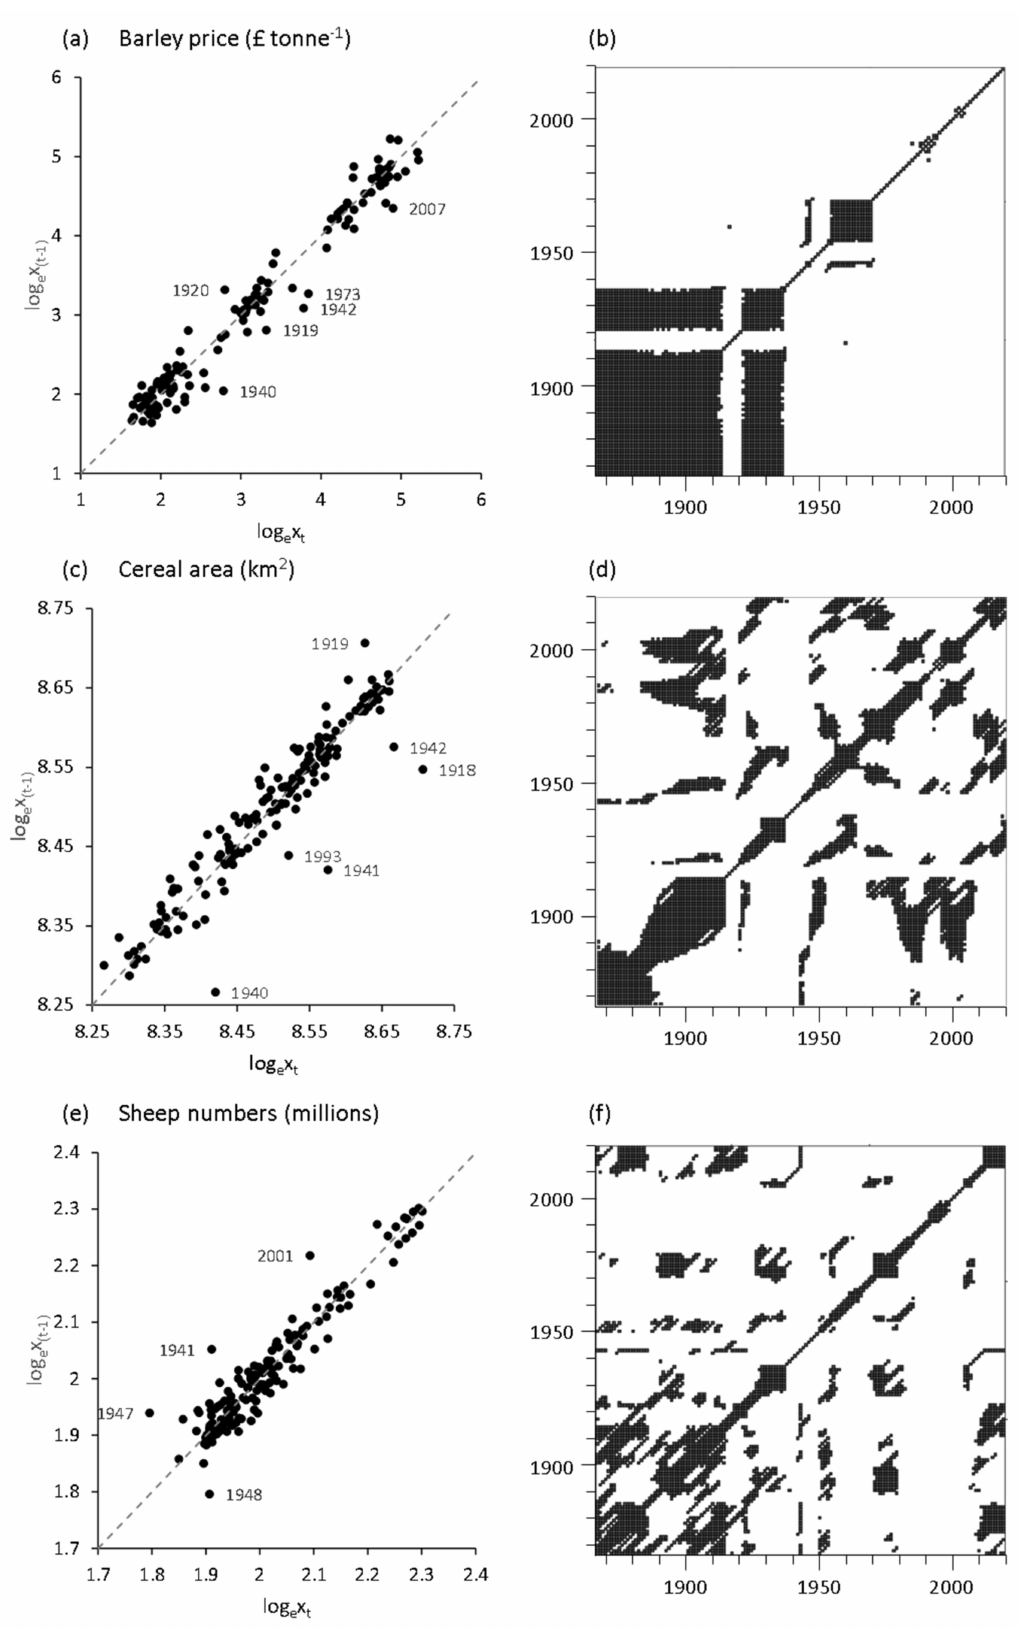
Figure 3. Lag plots and Recurrence Plots for barely price, cereal area, and sheep numbers in Scotland (1867–2020). ( a ) lag plot and ( b ) RP for barley price, ( c ) lag plot, and ( d ) RP for cereal area, and ( e ) lag plot, and ( f ) RP for sheep